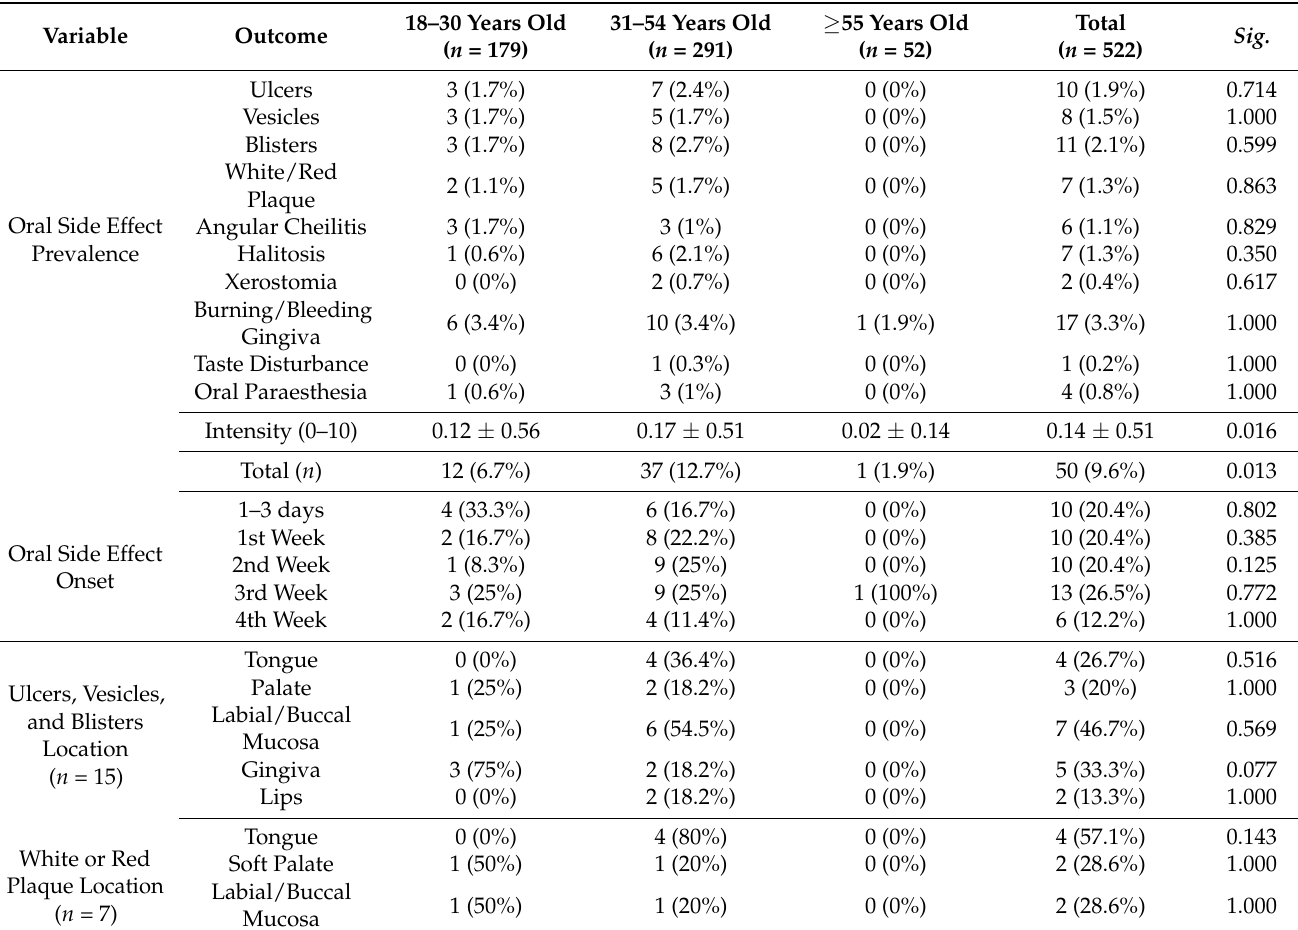
Table 7. Oral side effects of Slovak healthcare workers who received BNT162b2 and stratified by age group, February–March 2021 ( n =